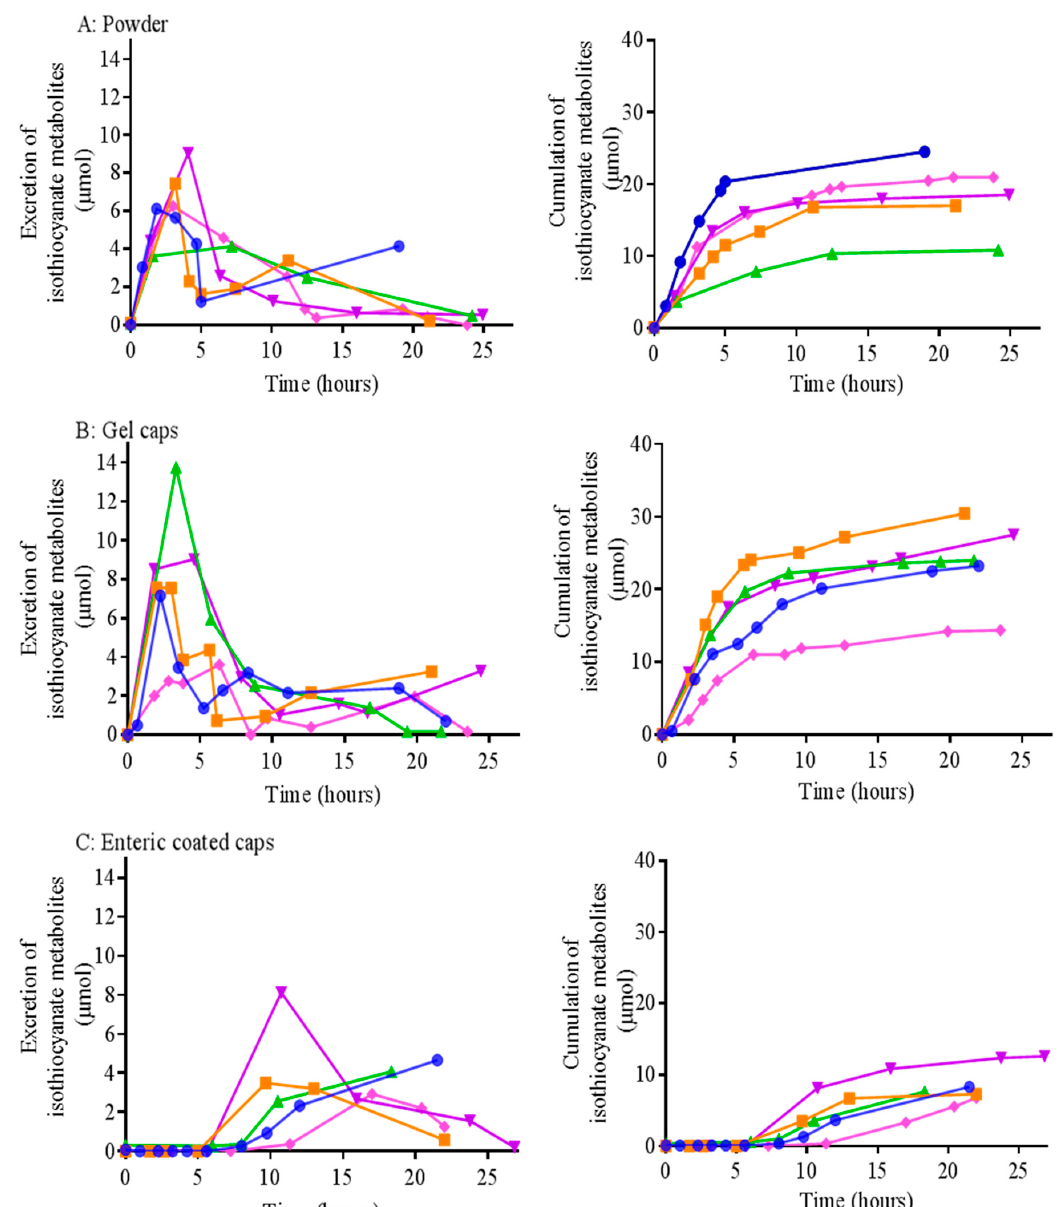
Figure 4. Encapsulation of broccoli sprout powder and the e ff ect on urinary excretion of isothiocyanate metabolites. Five healthy individuals ingested 1 g of broccoli sprout powder delivered using water ( A ), standard gelatin capsules ( B ) or Eudragit ® L100 polymer coated capsules ( C ) containing the equivalent of 1 g powder per three capsules. Urine samples were collected at baseline and over 24 h after ingestion of broccoli sprout powder. Samples were processed by the cyclocondensation assay and analysed by HPLC with UV detection. Pharmacokinetic data are shown on the left hand and corresponding cumulative data are shown on the right hand. No significant differences were detected between normal capsules and broccoli sprout powder delivered in water ( p = 0.224; one way repeated-measures ANOVA with Tukey’s multiple comparisons test). Enteric coated capsules showed a delay in the peak, but significantly lower isothiocyanate metabolites compared to the powder or normal capsules ( p = 0.029, 0.003 respectively; one way repeated-measures ANOVA with Tukey’s multiple comparisons tests). Different participants are indicated by different coloured lines and symbols ( n = 5).